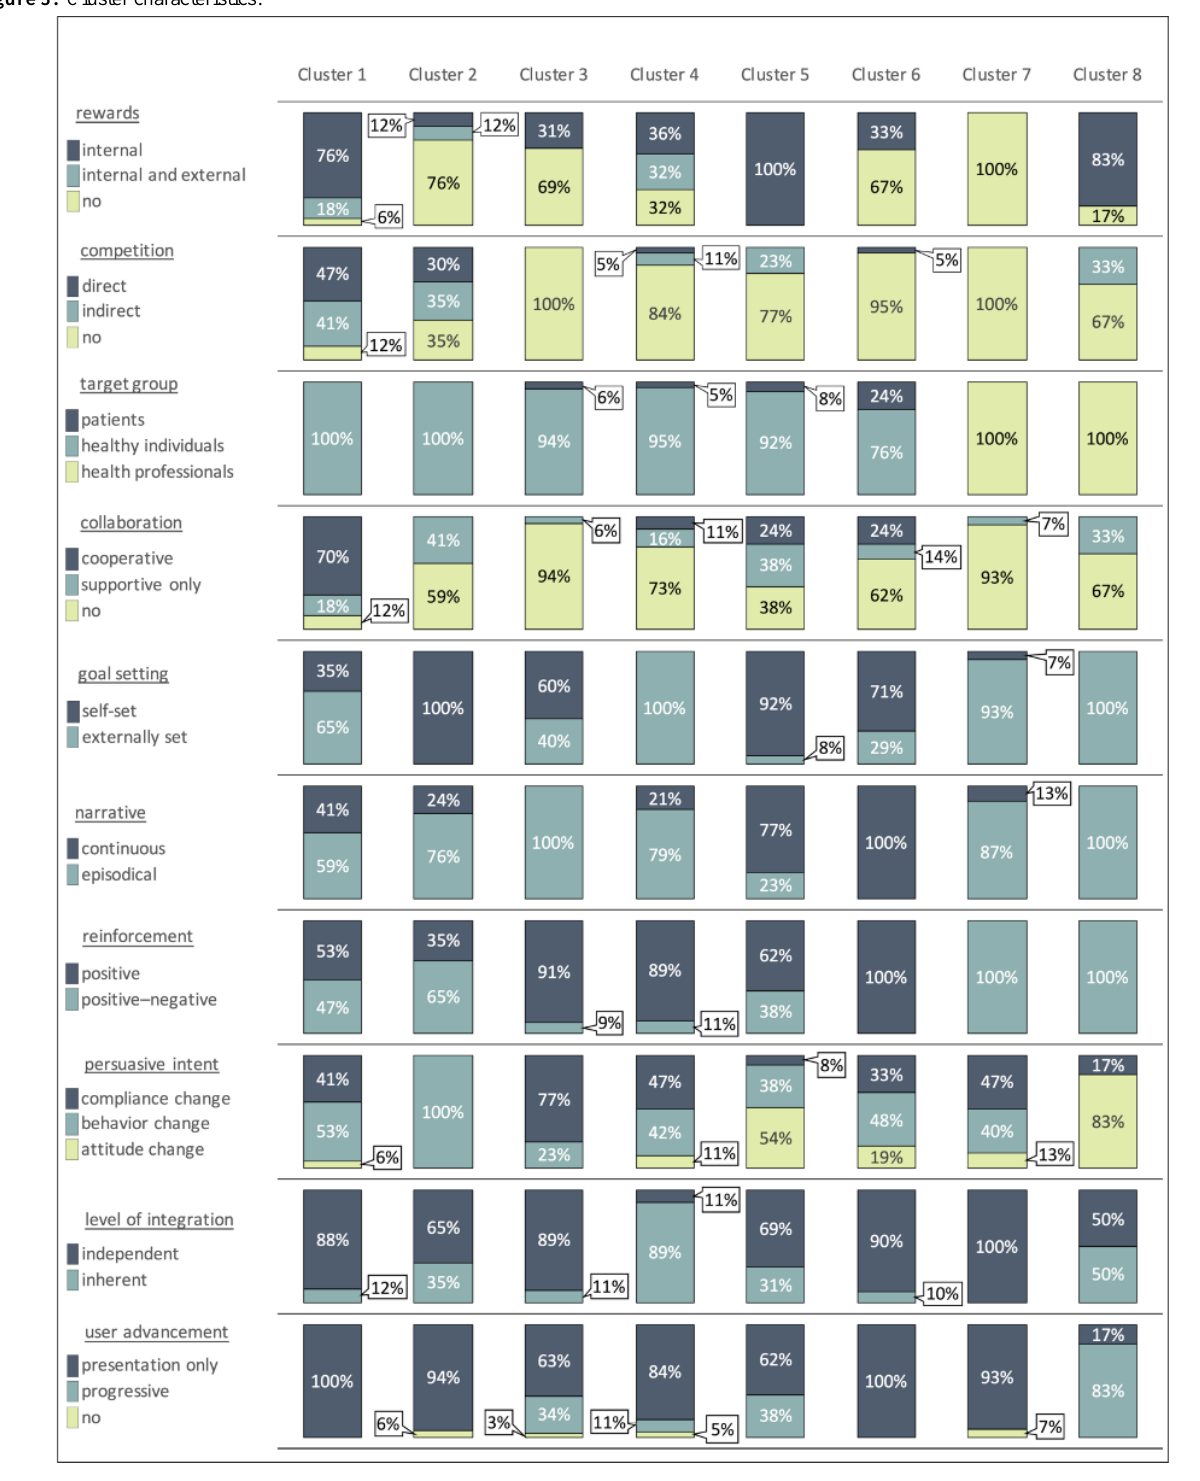
Figure 3. Cluster